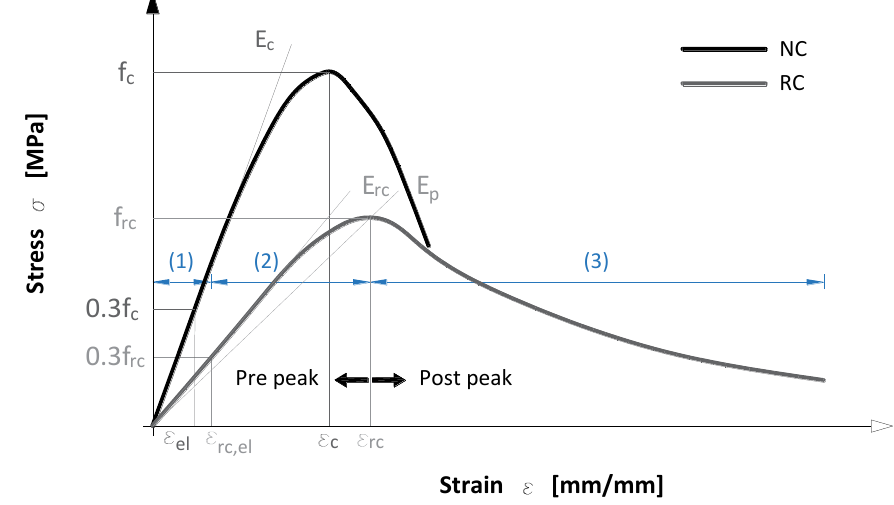
Figure 2. Stress-strain curve which describes mechanical parameters needed for establishing constitutive model of rubberized concrete.